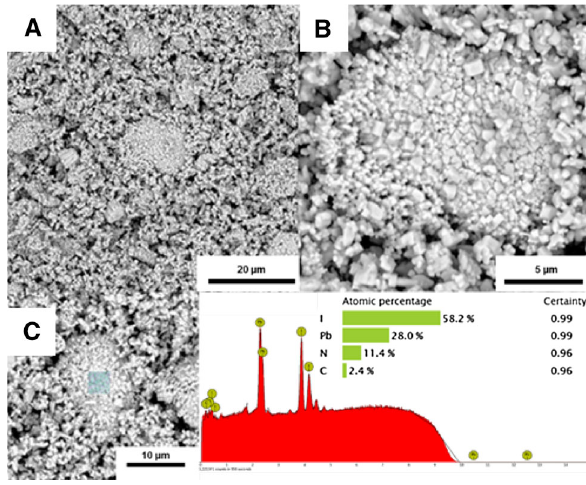
Fig. 7 SEM images and EDX spectrum of the perovskite film stored at RH 30 % for 70 days, a at 20 l m scale, and b at 5 l m scale, and c EDX spectrum acquired in a square area of image c , scale bar is 10 l